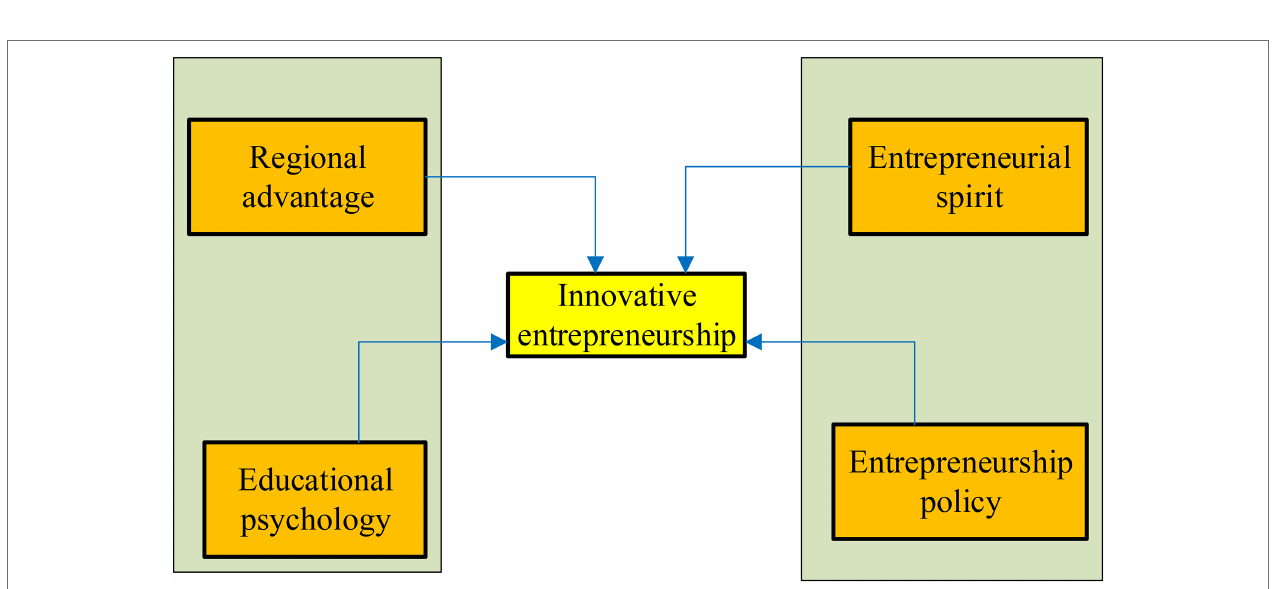
FIGURE 2 | Technology roadmap.